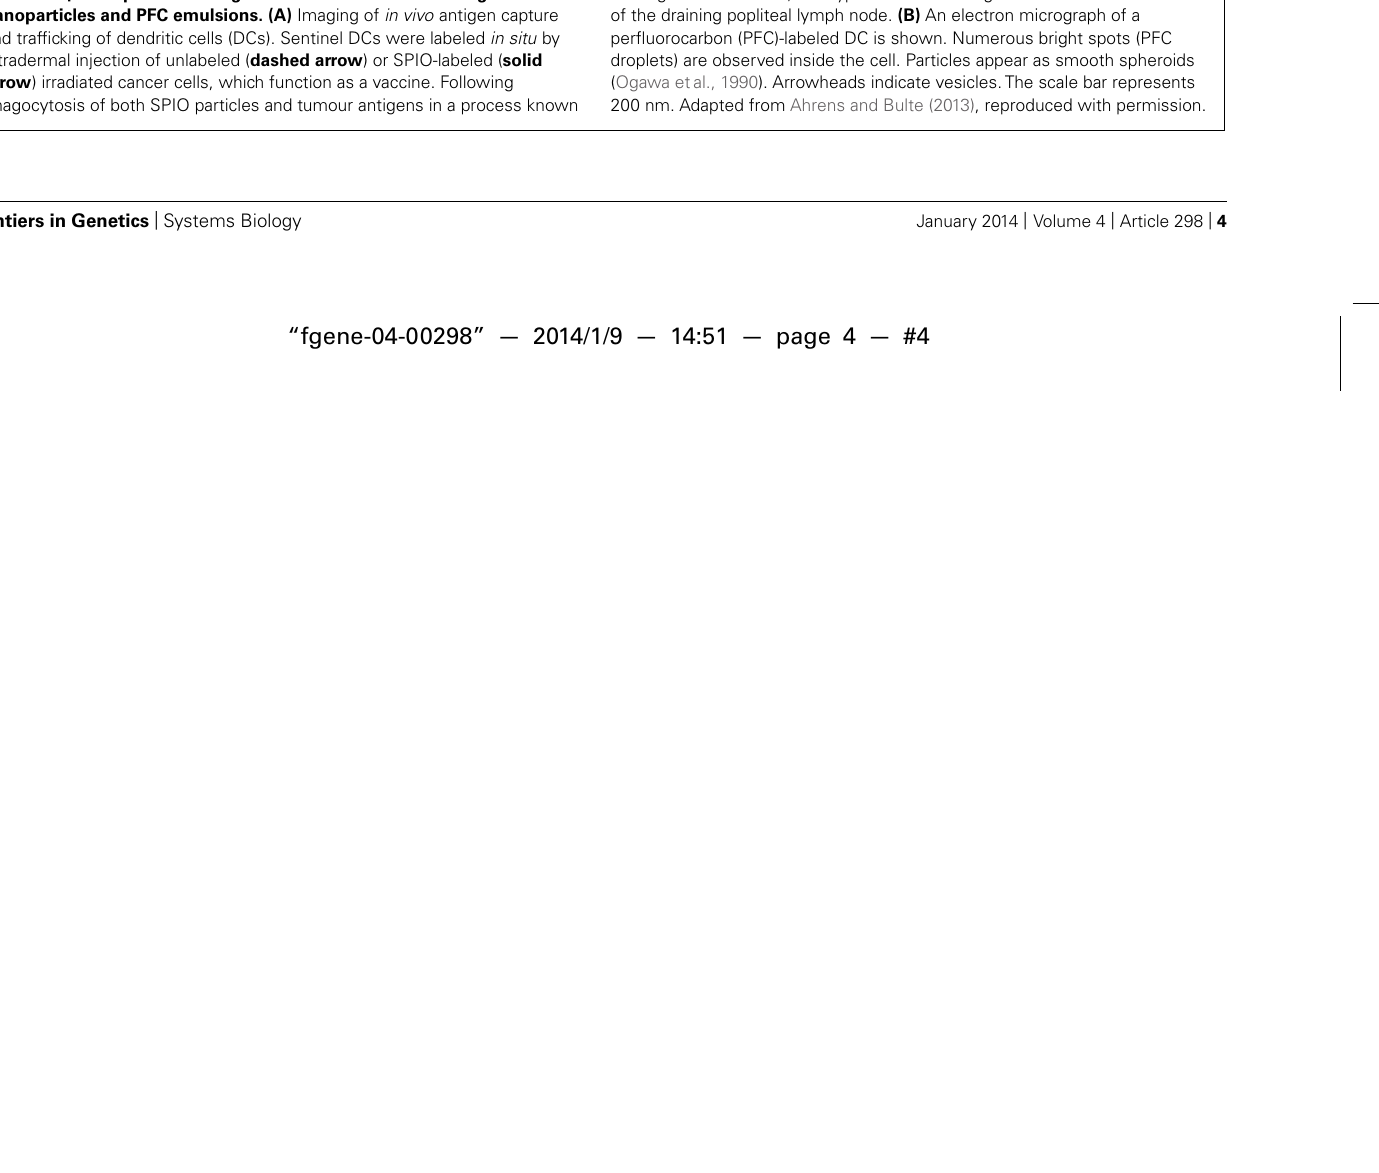
FIGURE 2 | Example of tracking immune cells with MRI using SPIO nanoparticles and PFC emulsions. (A) Imaging of in vivo antigen capture and trafficking of dendritic cells (DCs). Sentinel DCs were labeled in situ by intradermal injection of unlabeled ( dashed arrow ) or SPIO-labeled ( solid arrow ) irradiated cancer cells, which function as a vaccine. Following phagocytosis of both SPIO particles and tumour antigens in a process known